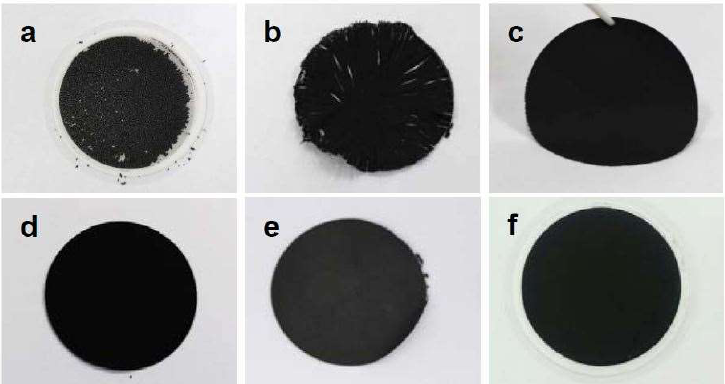
Figure 6. Optical images of the fabricated rGO papers after sonication treatments for ( a ) 2, ( b ) 4, ( c ) 6, ( d ) 10, ( e ) 14, and ( f ) 20 h.